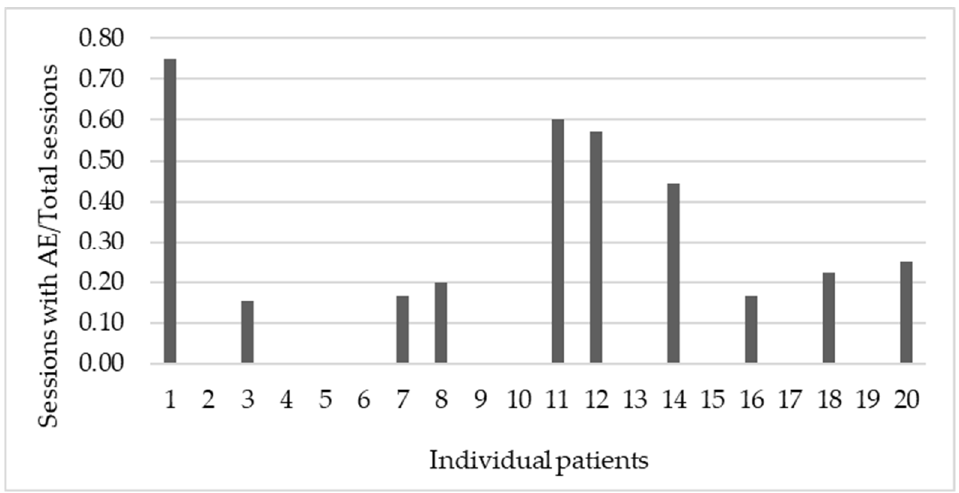
Figure 2. The y-axis represents the ratio between the number of sessions with AEs reported and the total number of stimulation sessions. The x-axis shows the individual patients displaying different levels of tolerability. The patients differed greatly in their reporting of AEs. Whereas some patients had a high ratio signifying frequent AE/ADEs, other patients did not report any AEs.